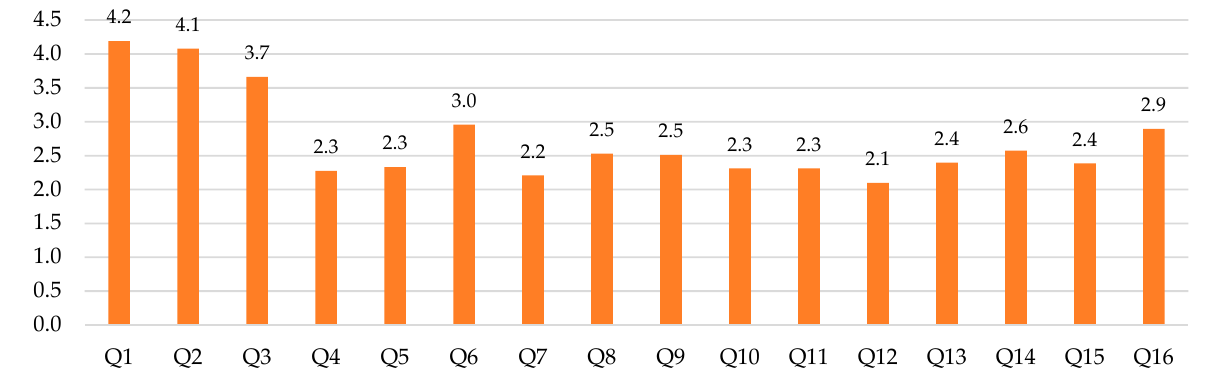
Figure 4. Mean score for each DISCERN question.